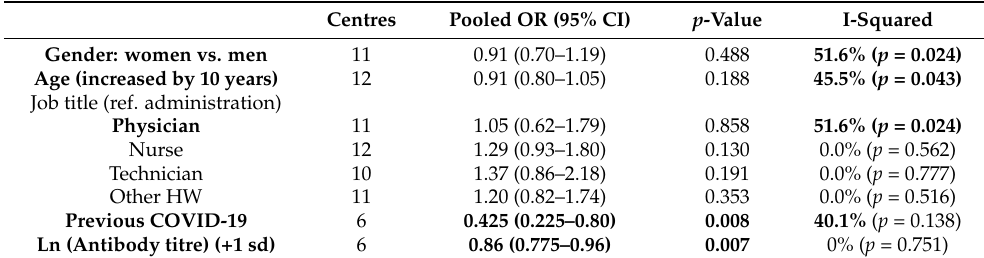
Table 3. Summary of meta-analyses performed on all 12 centers with available aggregate data.